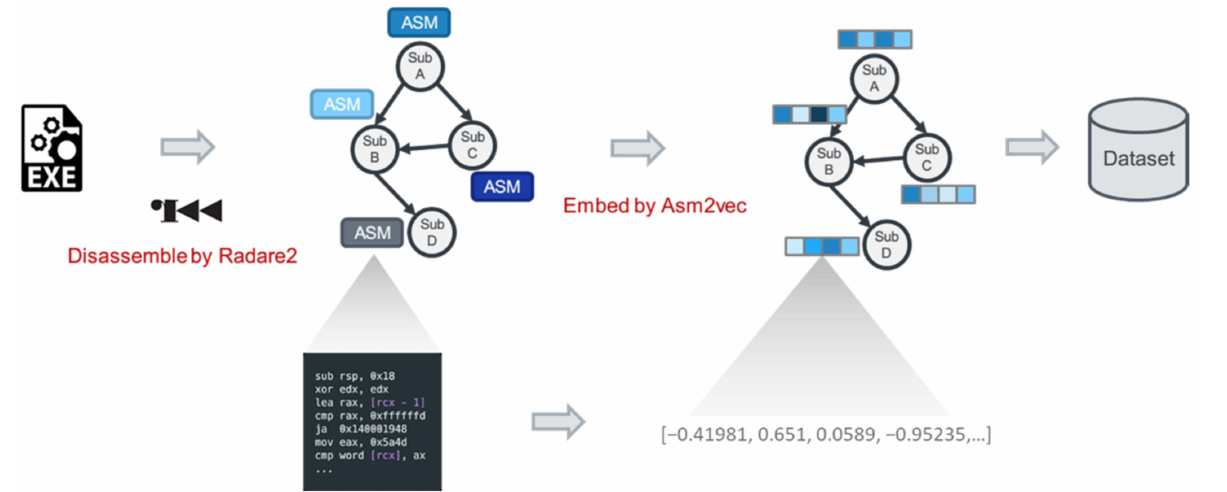
Figure 3. The procedure of dataset